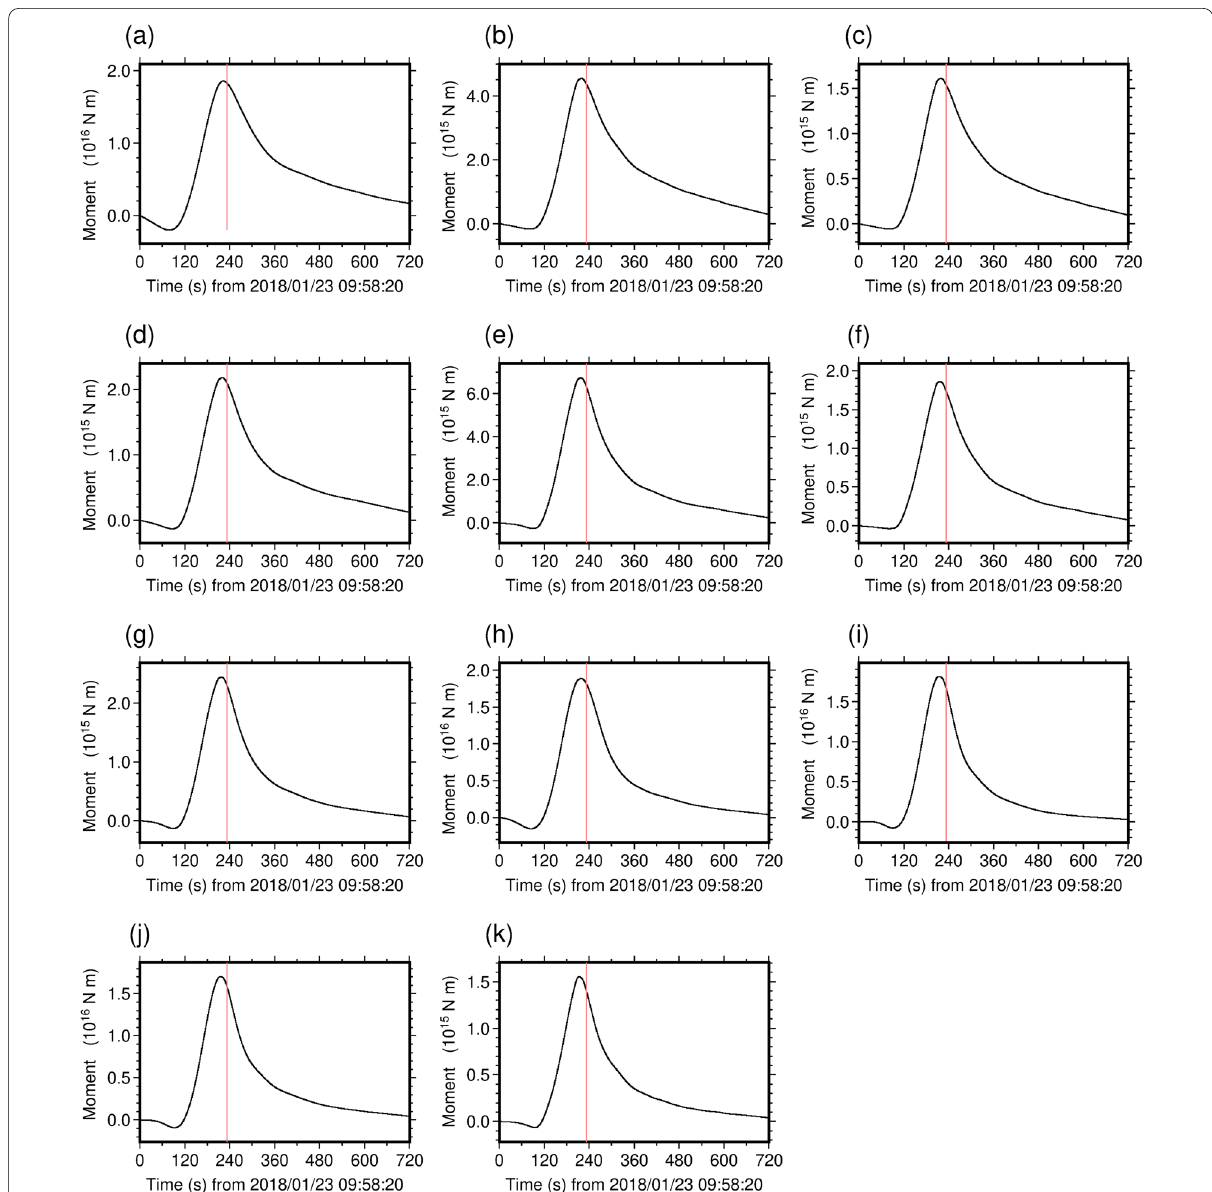
Fig. 9 Source time functions of all the candidate sources. The red line indicates the time of the eruption